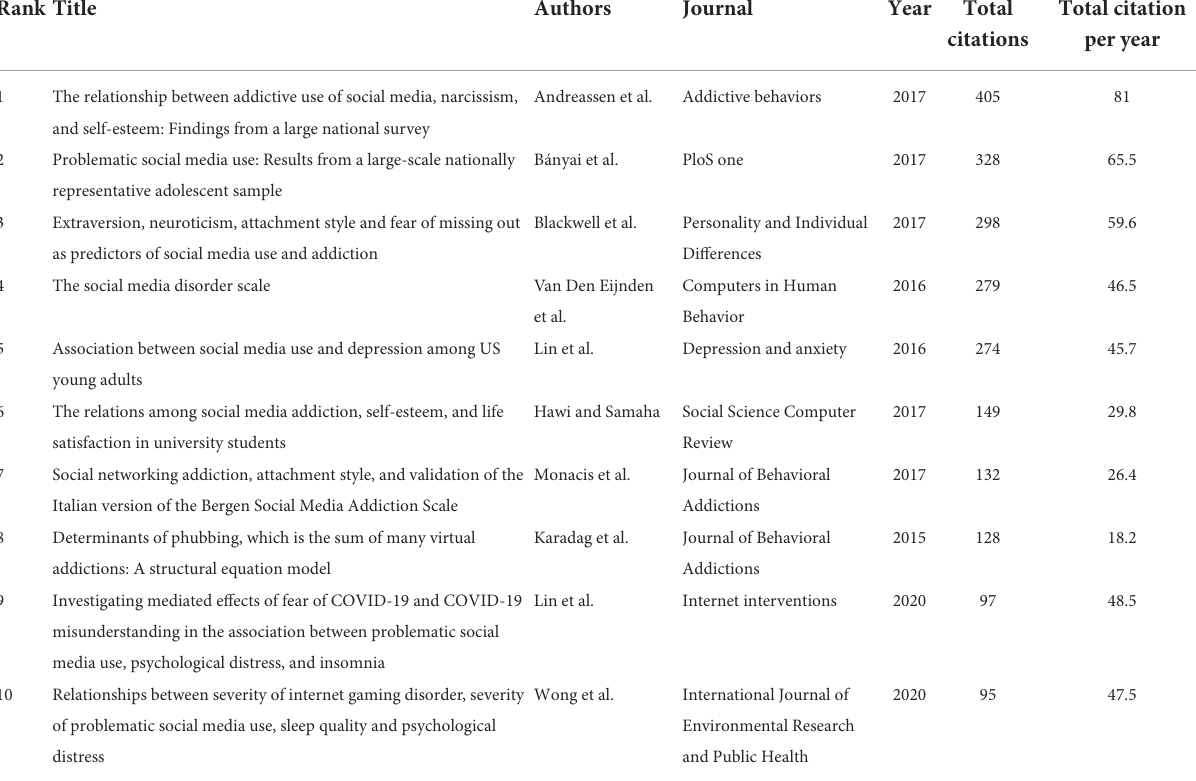
TABLE 2 Top 10 most cited and more frequently mentioned documents in the field of social media